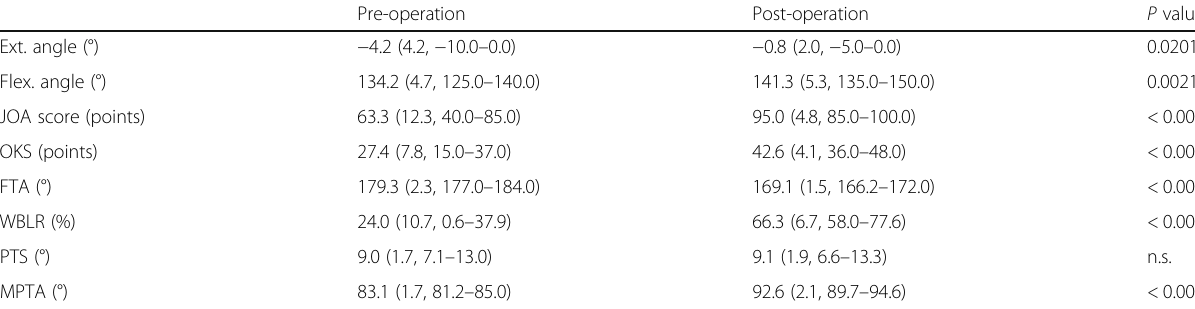
Table 3 Preoperative and postoperative comparison of clinical and radiological outcomes Pre-operation